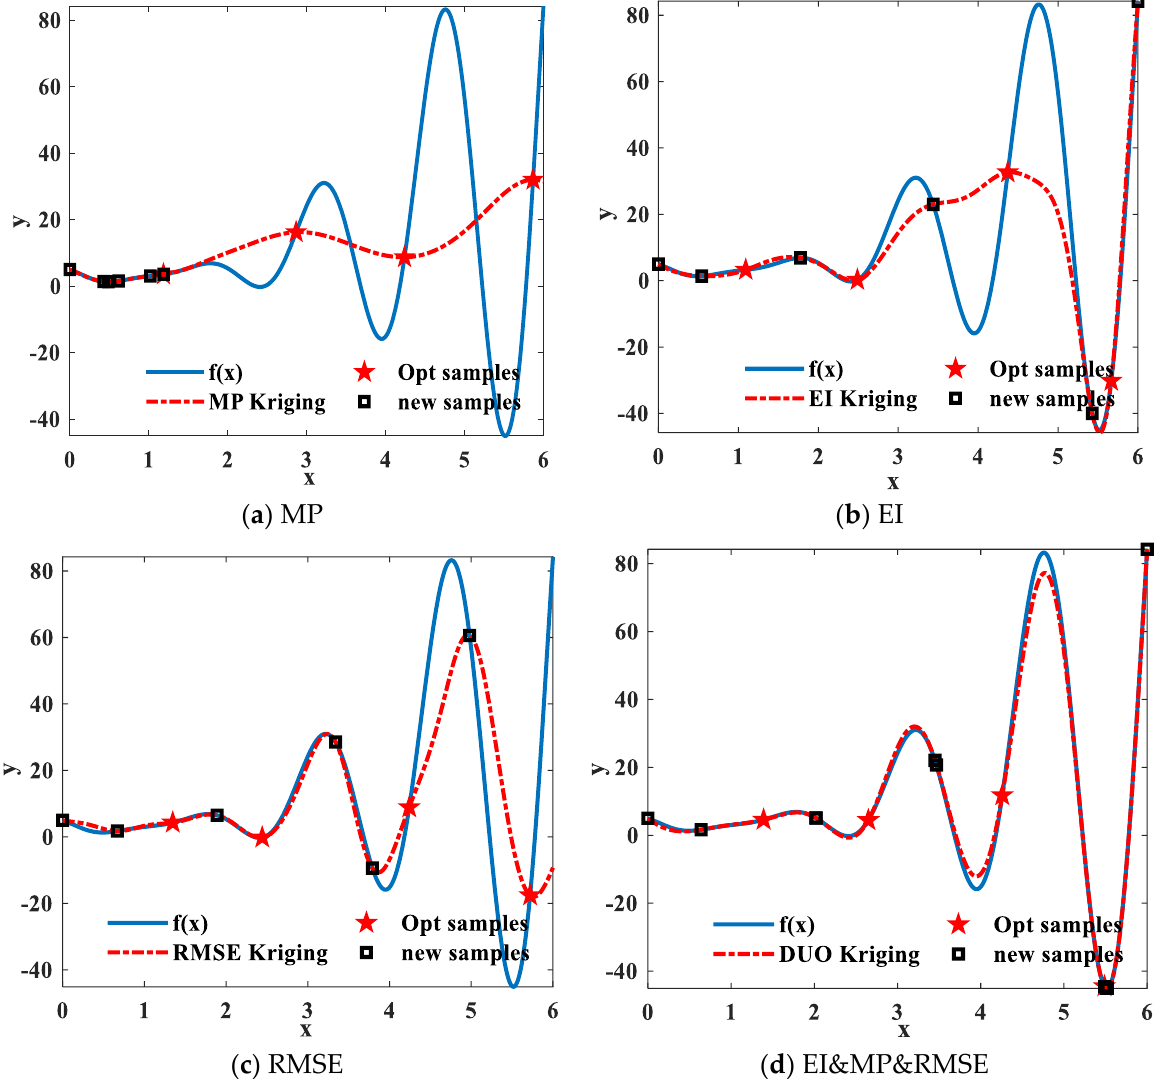
Figure 2. Comparison and verification of 1−D function.